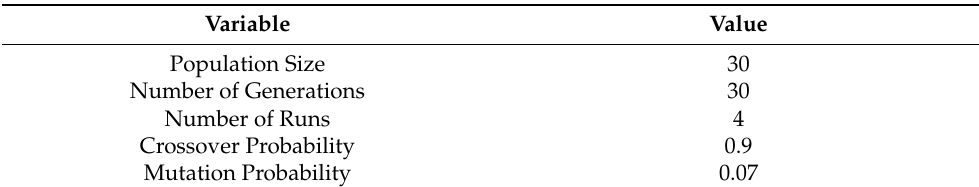
Table 3. Genetic algorithm variables.